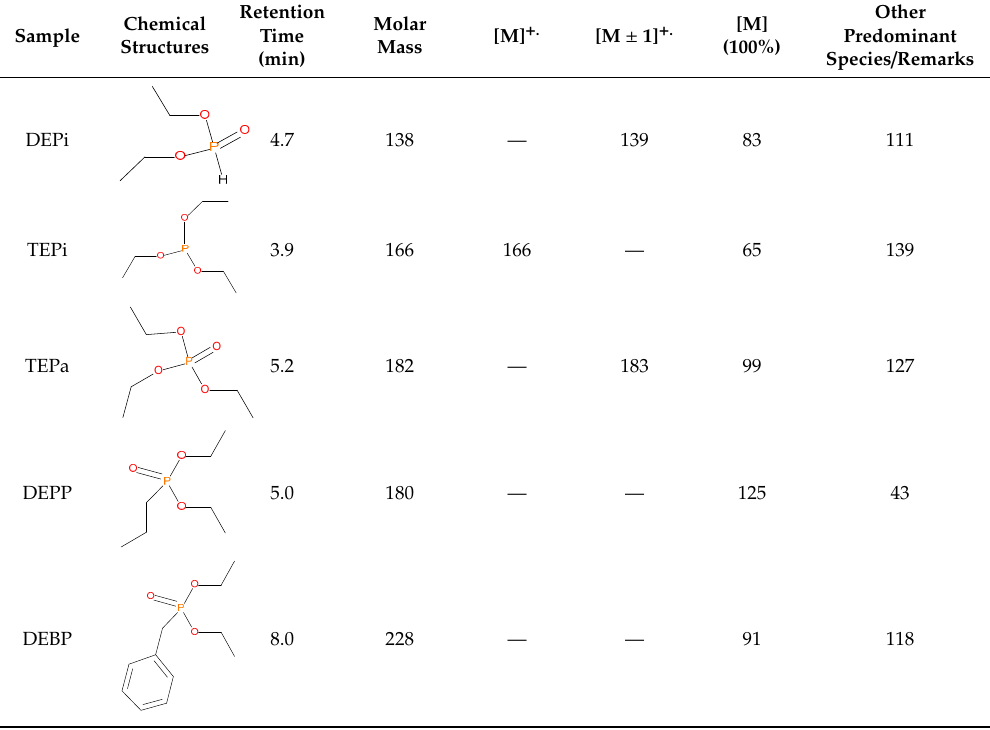
Table 4. Retention times and fragmentation features of the various liquid additives.